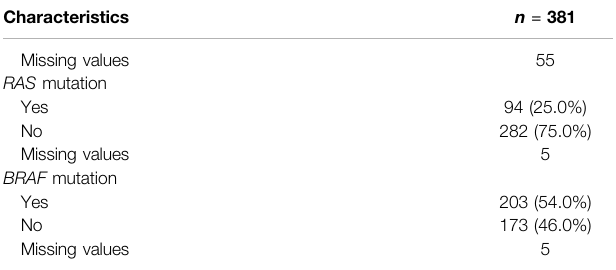
TABLE 1 | Patient and tumor characteristics. TABLE 1 | ( Continued ) Patient and tumor